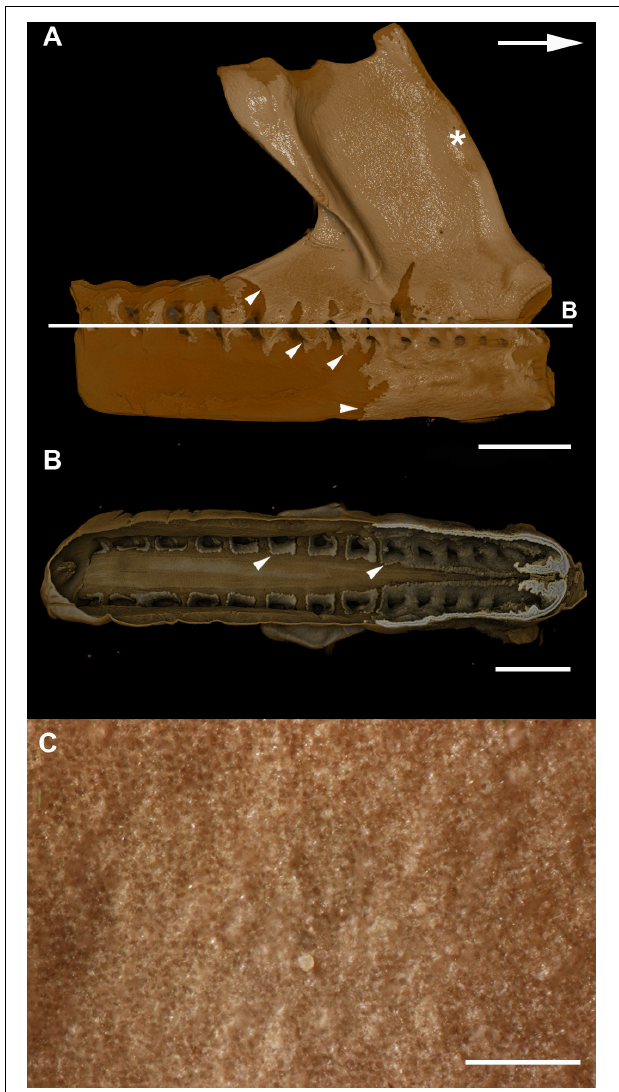
FIGURE 11 | (A,B) micro–CT scan of a synarcual from an adult Callorhinchus milii (Holocephali; Callorhinchidae). (A) synarcual, lateral view; (B) coronal section (virtual) through synarcual; (C) macrophotograph of lateral synarcual surface showing mineralization with a granular appearance. Figures 11A,B from Johanson et al. (2015). Usage permitted under CC BY licensing.